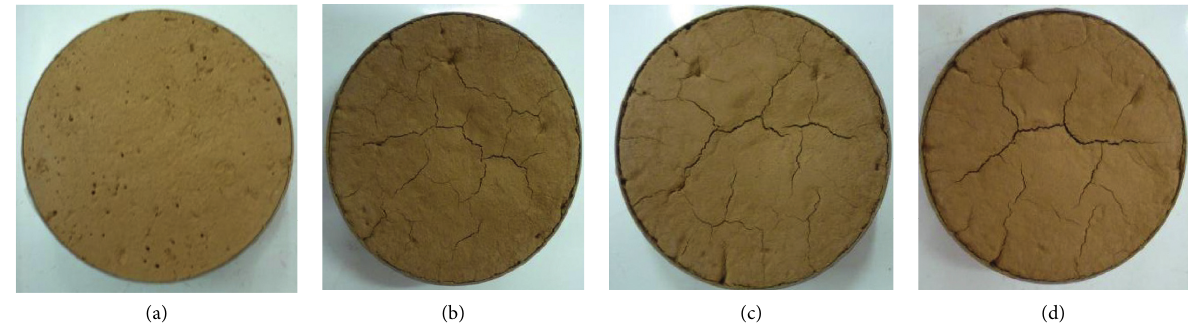
Figure 4: Surface characteristics of Luochuan loess macrostructure during a dry-wet cycle when Δ w � 5%. (a). Initial state. (b). One cycle. (c). Three cycles. (d). Five cycles.